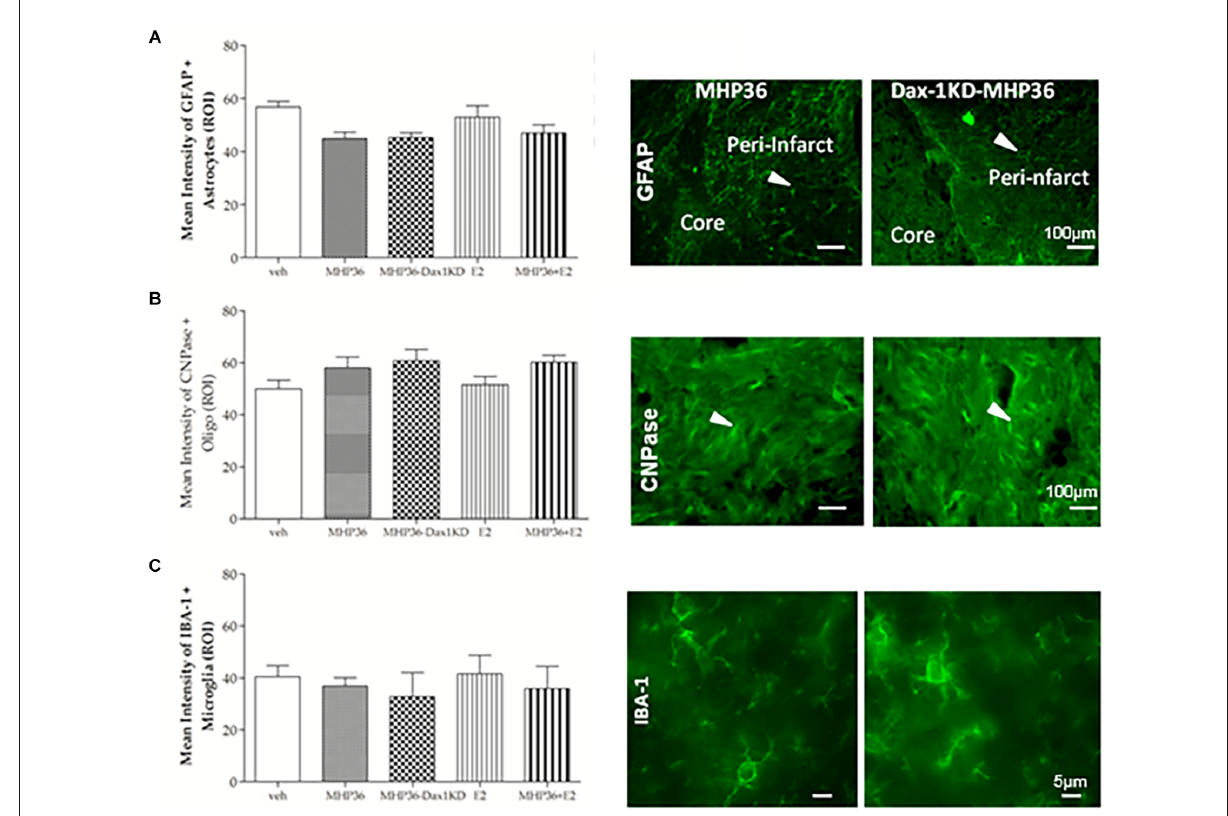
FIGURE8 Mean intensity staining for markers of astrocytes, oligodendrocytes, and microglia. Graphical representation of mean average intensity staining in the peri-infarct cortex for (A) GFAP (astrocytes), (B) CNPase (oligodendrocytes), and (C) IBA-1 (microglia) markers in all experimental groups, with representativeimagesfromMHP36andMHP36-Dax1KDonright.Therewasnostatisticaldifferenceinexpressionprofilesacrosstheexperimental groups; n = 3.